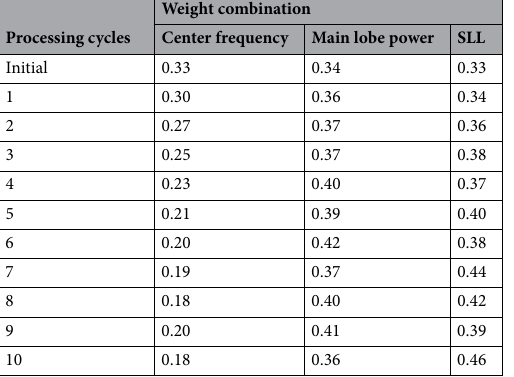
Table 1. Weighting factor evolution by Delphi Method. The weight of center frequency decreases gradually, and as a contrast, the weight of SLL had a slight increment. The phenomenon indicated that we should grant more weight to